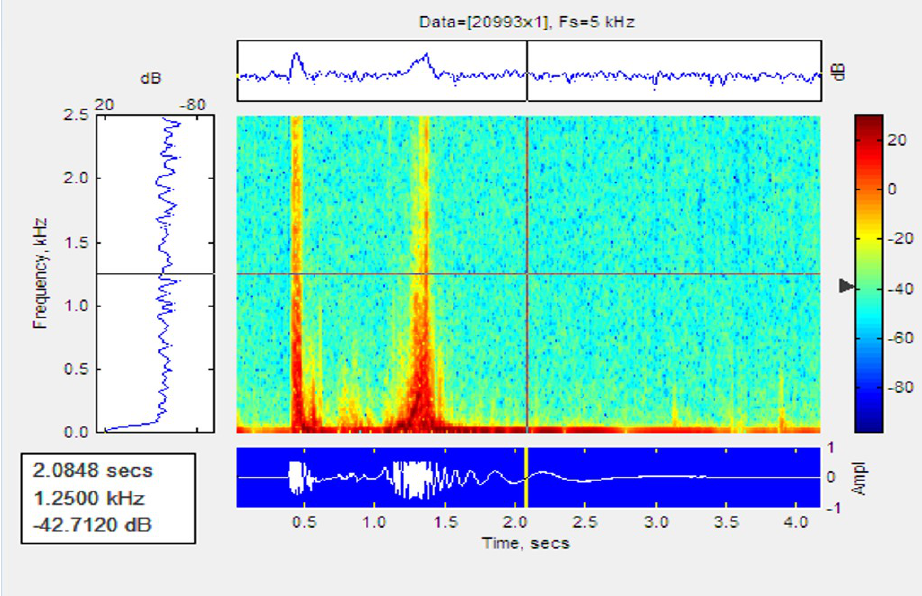
Figure 17. Spectogram of signal for the walk of a single person.